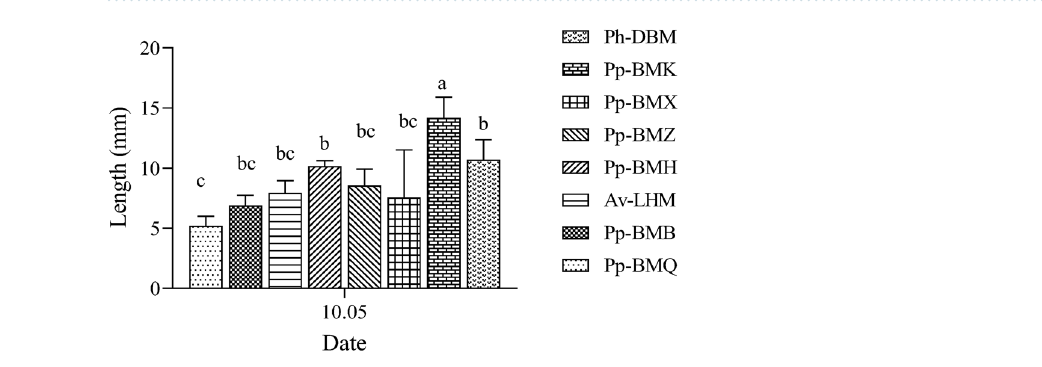
Figure 13. The length of necrosis lesions of eight ecotypes stems inoculation with B. exigua var. rhapontica mycelial plugs under greenhouse